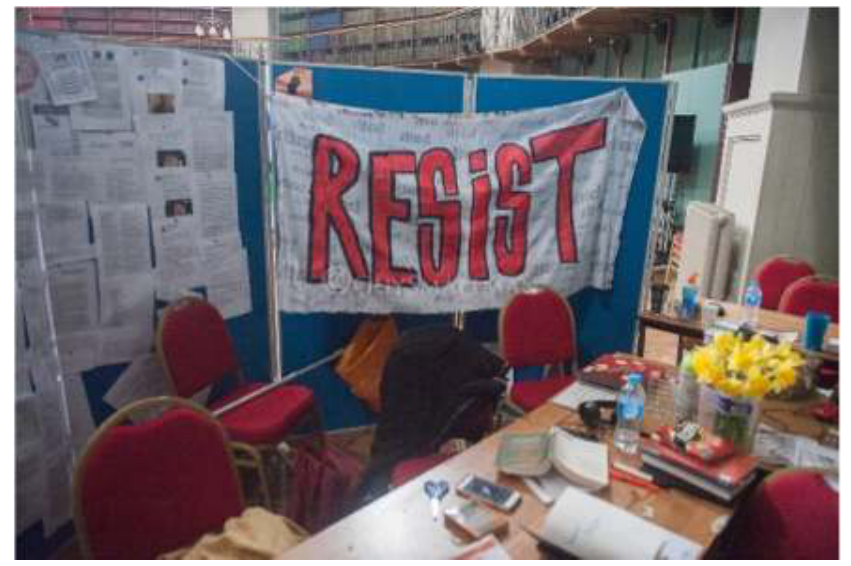
Source: Left Foot Forward, 2018.